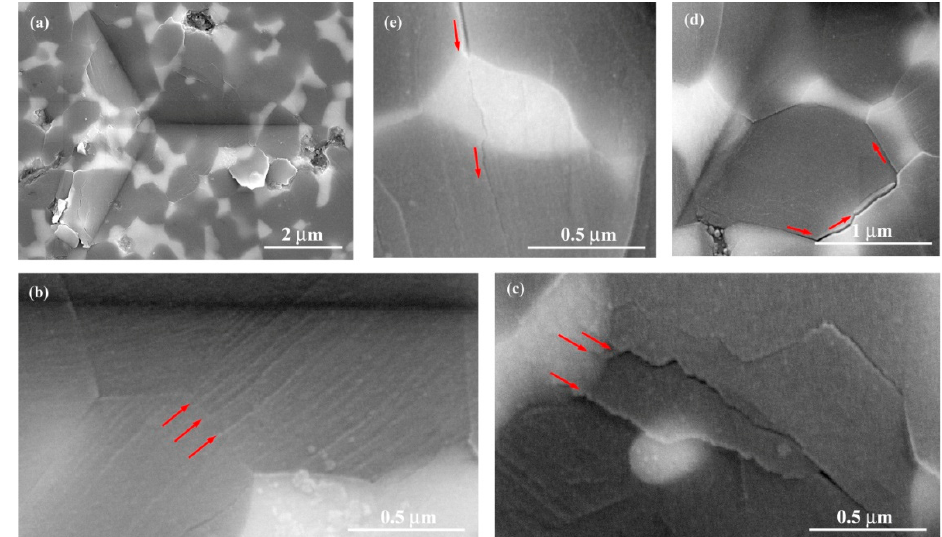
Figure 4. SEM images of shear deformation bands and microcracking formation inside the nanoindentation imprint under peak load of 500 mN for ZTA30: ( a ) typical overview of the imprint; ( b ) magnified view of shear deformation band group denoted by parallel arrows; ( c ) propagation of microcracking along shear deformation band; ( d ) intergranular fracture along alumina/YSZ boundaries; ( e ) transgranular fracture across the YSZ grain.